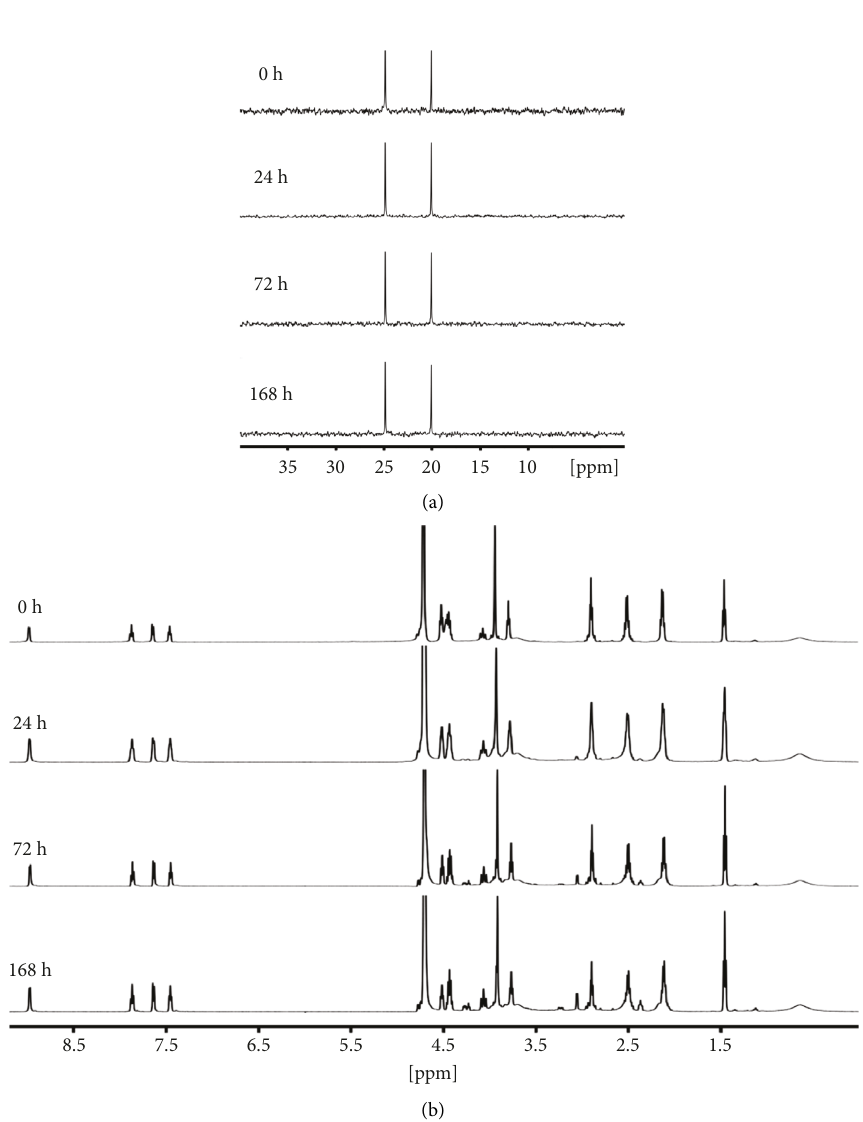
Figure 6: (a) 31 P NMR, and (b) 1 H NMR spectra at different intervals for DBPP (1.12 × 10 − 2 M in the presence of GSH 2.64 × 10 − 2 M at 37 °